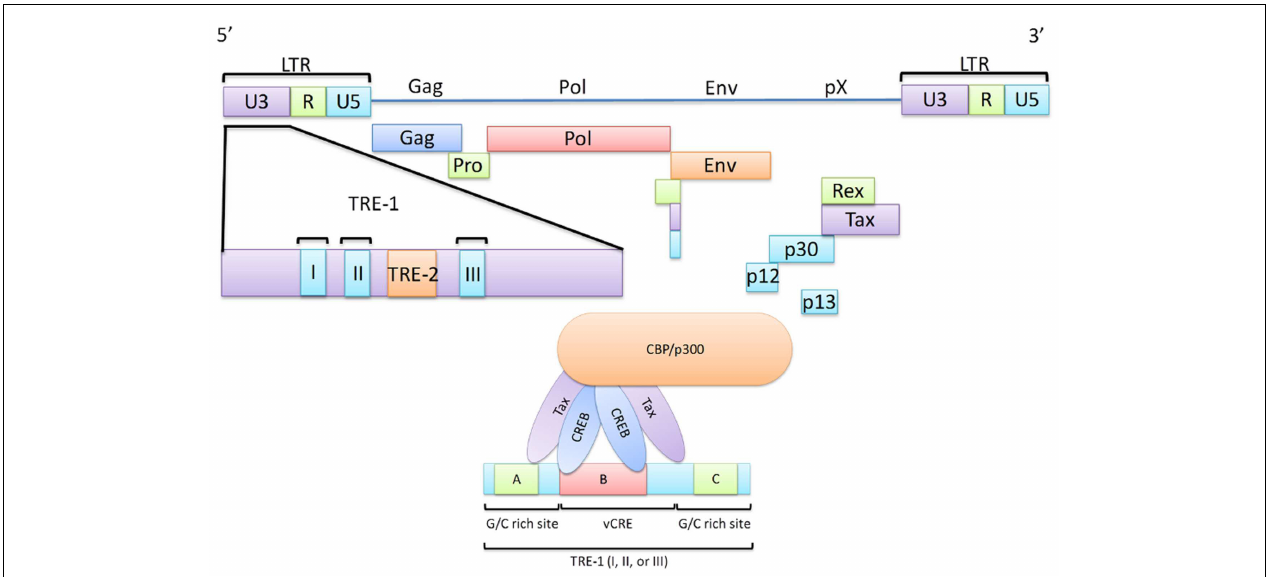
LTR is divided into the U3, R, and U5 regions.The U3 region is of significant importance inTax-mediated transcription and thus is highlighted.This region contains threeTRE-1 regions, each capable of recruitment of the Tax/CREB/CBP/p300 complex.TRE-1 is shown to contain three domains (A, B, and C) of which B, in conjunction with either A or C, is required for the Tax/CREB/CBP/p300 complex to bind to the